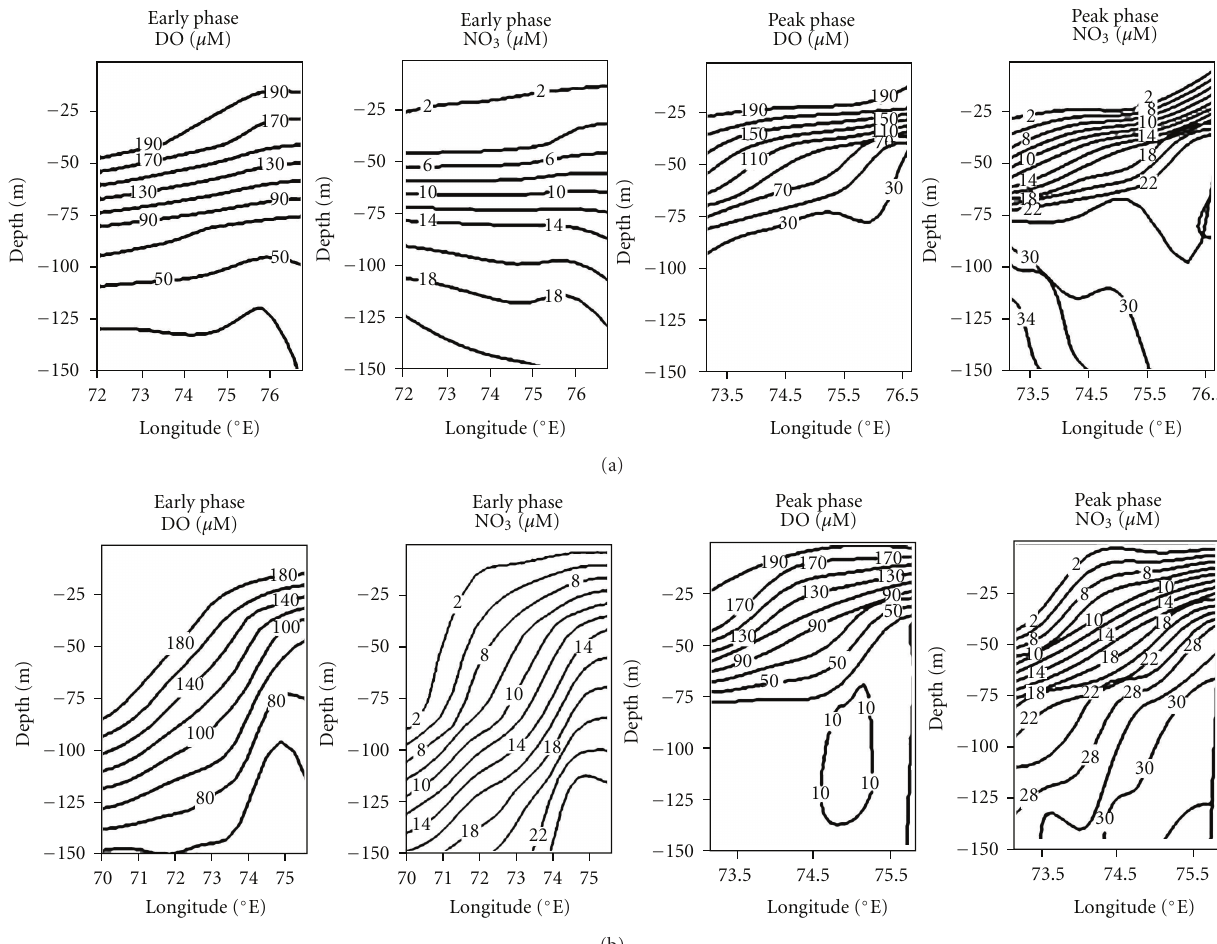
Figure 4: Vertical profile of dissolved oxygen ( µ M) and nitrate ( µ M) during early and peak phases of summer monsoon along 8 ◦ N (a) and 10 ◦ N